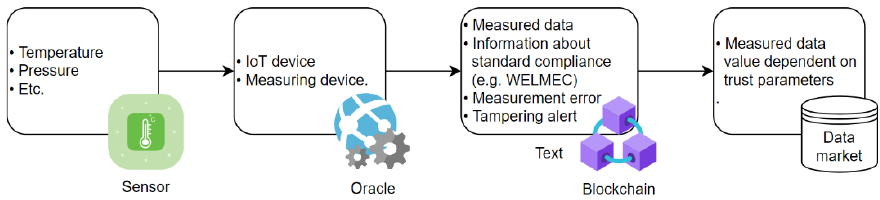
Figure 3. Information about measured data relevant for a data market.